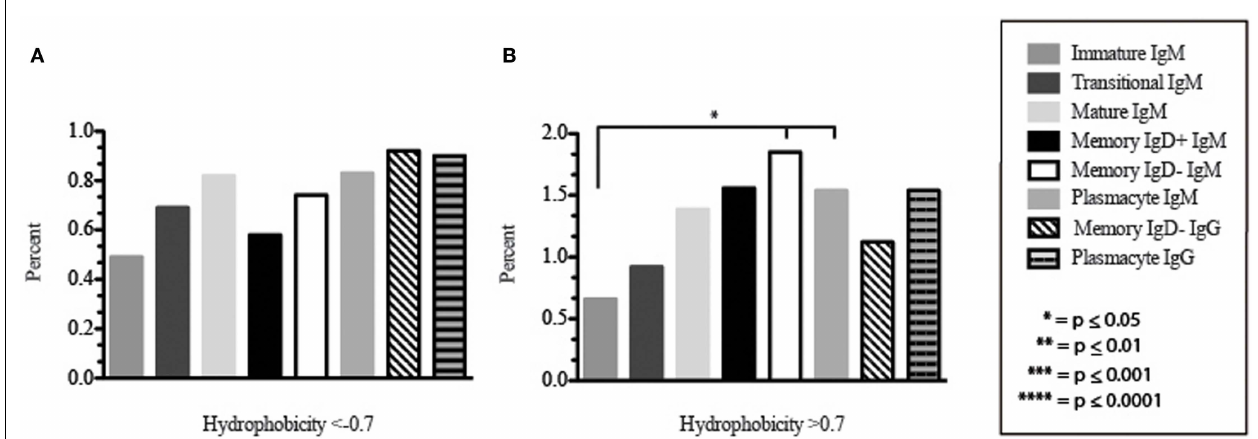
Eisenberg (49) has been used to calculate average hydrophobicity (23). Prevalence is reported as the percent of the sequenced population of unique, in-frame, open transcripts from each B lineage fraction. All comparisons were made using χ 2 -test or Fisher’s exact test as appropriate. Significant differences among each fraction in the different mice are indicated by asterisks: * p ≤ 0.05, ** p ≤ 0.01, *** p ≤ 0.001, **** p ≤